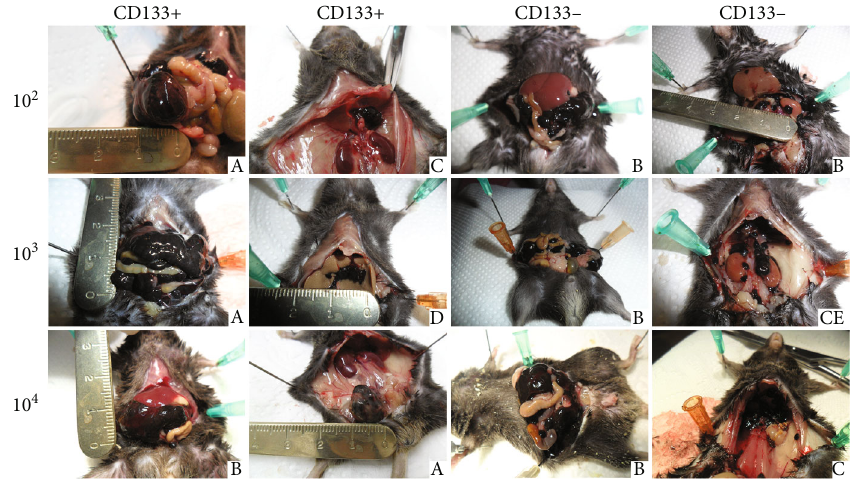
Figure 4: Tumor development depending on density and phenotype of implanted B16-F10 cells. Examples of tumor placement: (a) peritoneum at the injection site, (b) intestinal mesentery, (c) diaphragm, (d) liver, and (e)